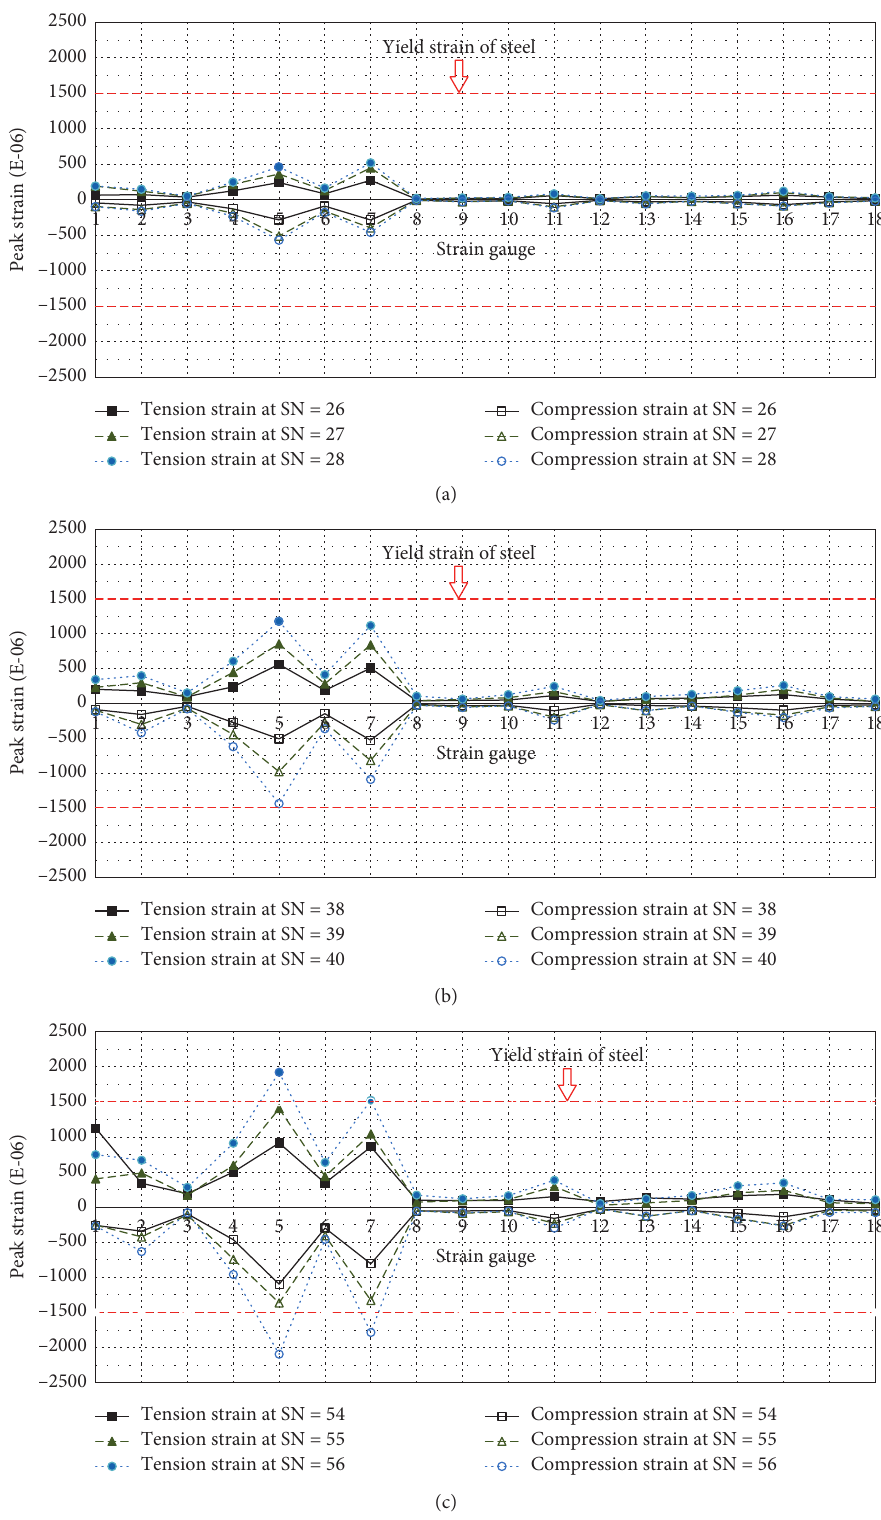
Figure 20: Peak strains of the braced frame and steel frame. (a) Sequence number from 26 to 28. (b) Sequence number from 38 to 40. (c) Sequence number from 54 to